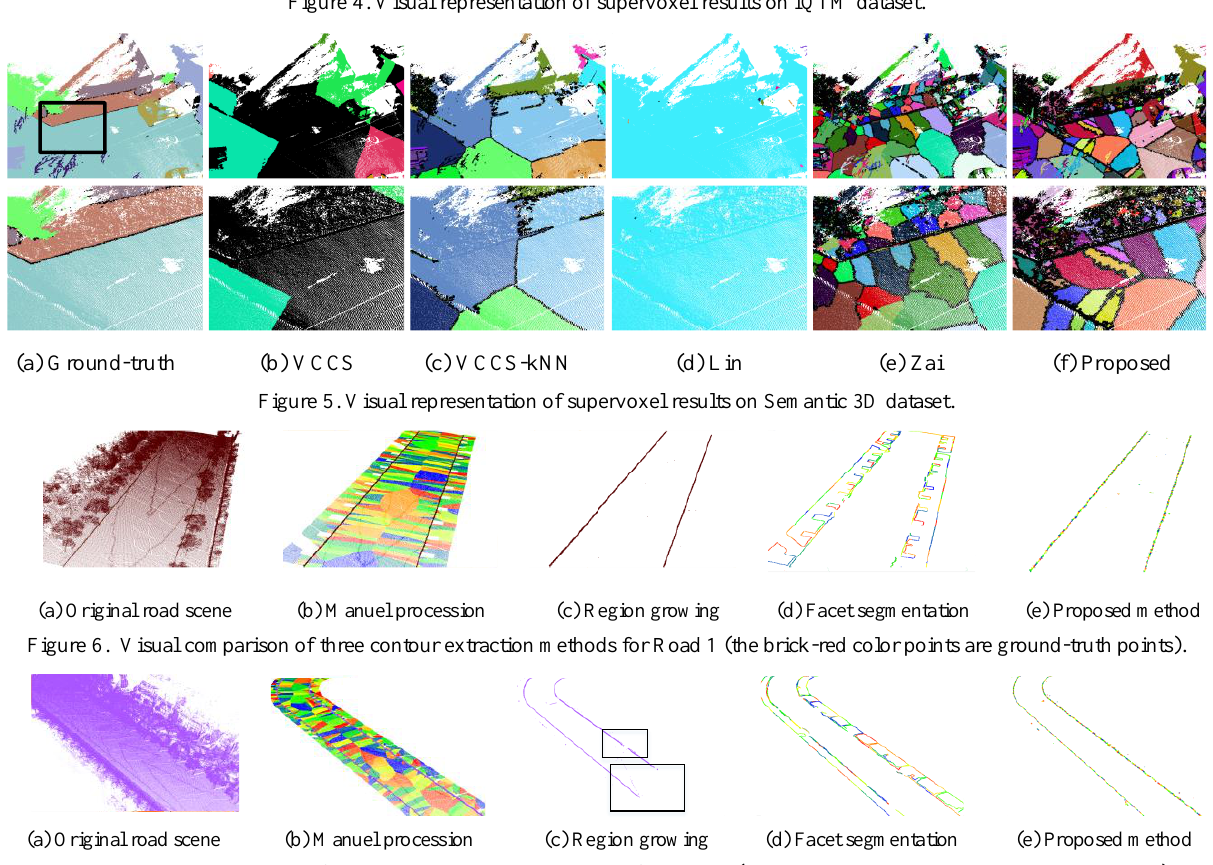
Figure 7. Visual comparison of three contour extraction methods for Road 2 (the purple color points are ground-truth